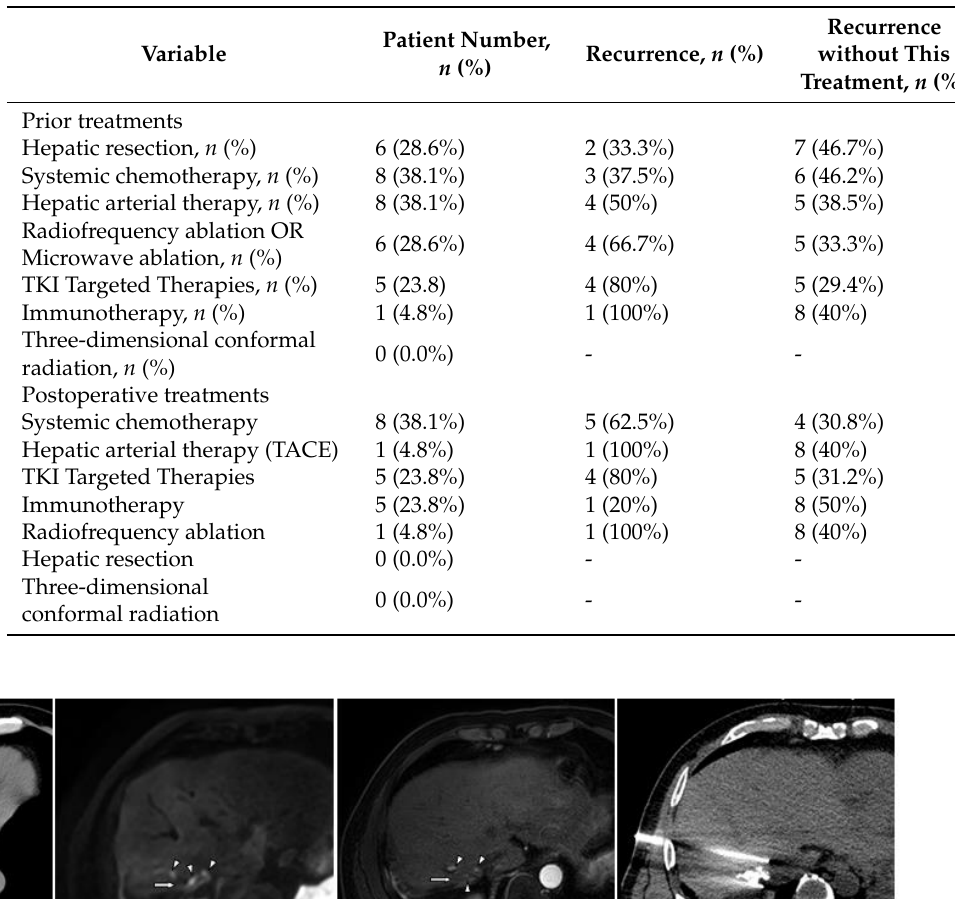
Table 5. Treatment and recurrence.